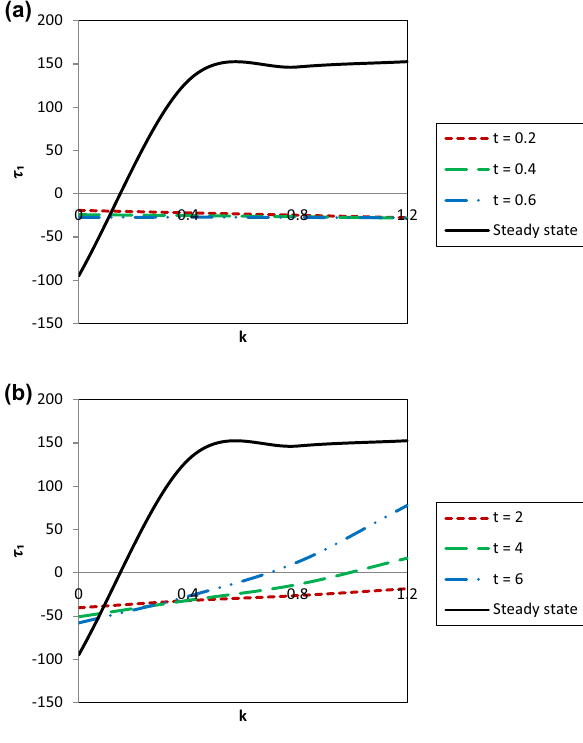
Fig. 5 a Variation of skin friction versus dimensionless thermopho- retic coefficient for different values of time at y = 1 ( Pr = 0.71, Sc = 100, 𝜆 = 100, b = 10, N c = 2.0, N t = 8.0, 𝛼 = 10, Bi 1 = Bi 2 = 10 ) . b Variation of skin friction versus dimensionless thermophoretic coefficient for different values of time at y = 1 ( Pr = 0.71, Sc = 100, 𝜆 = 100, b = 10, = 2.0, N = 8.0, 𝛼 = 10, Bi = Bi = 10 N 1 2 c t